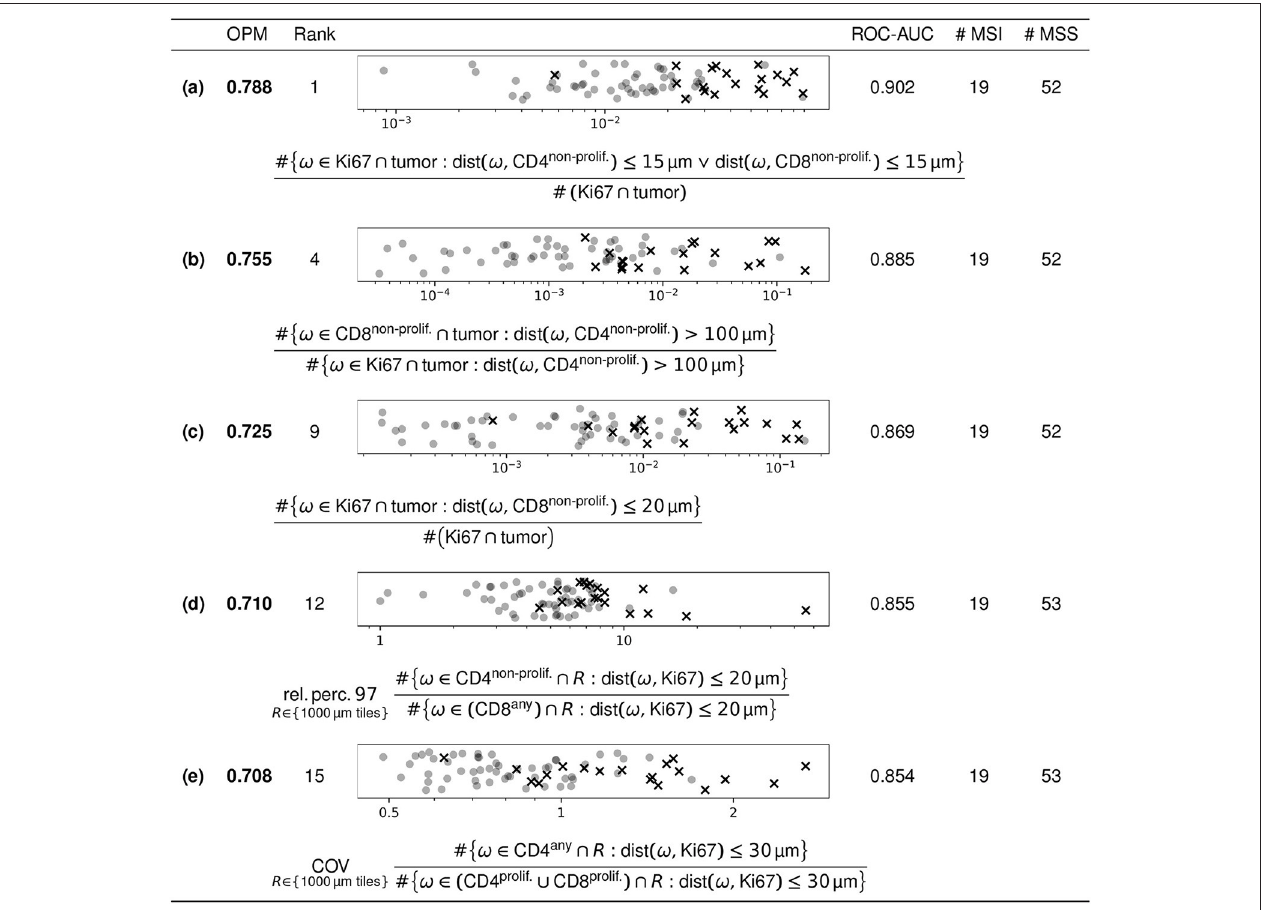
FIGURE 5 | Selected features with high discriminatory power. Of the 108,579 features included in our analysis, the figure shows five selected features of high discriminatory power. The parameters for the features shown are explained in the text. The scatter plots show the feature values of the respective feature (all of which are dimensionless), with MSI and MSS as crosses and circles, respectively. Data points are uniformly randomly scattered in vertical direction and plotted on a logarithmic horizontal scale.